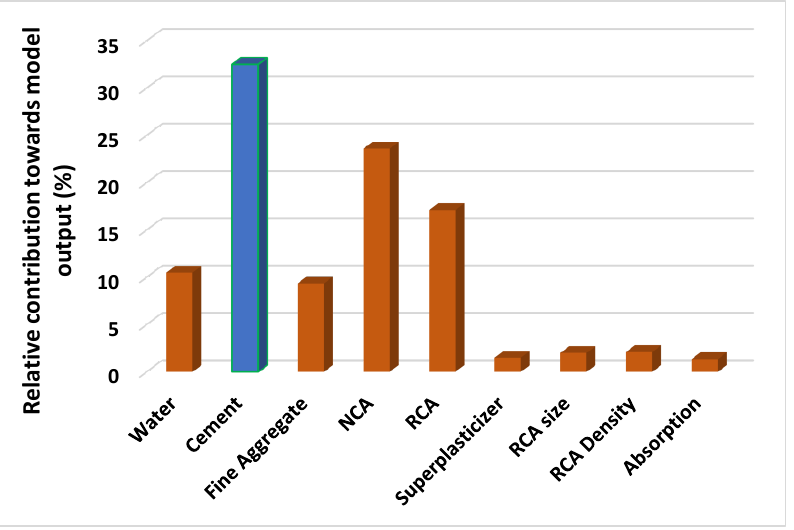
Figure 14. Input variables ’ contribution level in percentages to the anticipation of the outcome.